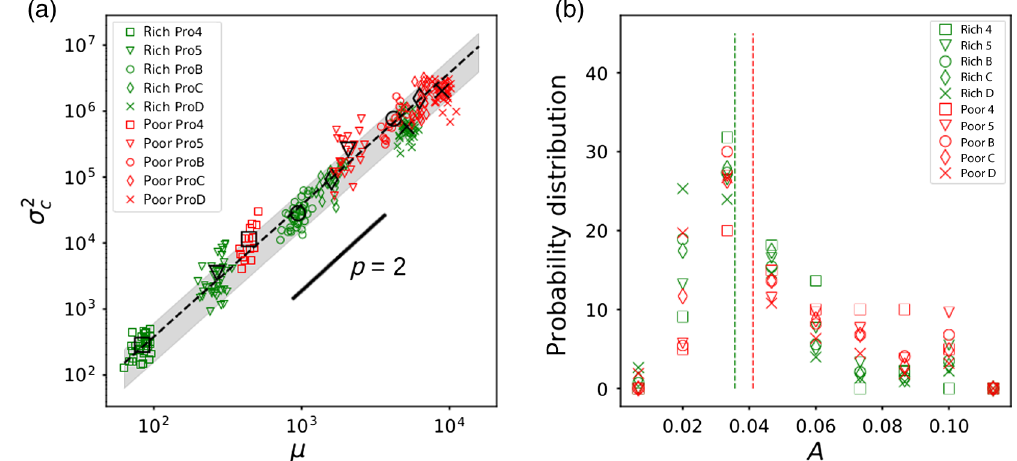
FIG. 2. TL in protein concentration fluctuations. (a) Variance ( σ 2 ) of the protein concentration versus the mean value μ ð¼ h c iÞ for c individual cells with all experimental conditions. The poor and rich nutrient conditions are labeled by red and green, respectively. Different symbols correspond to cells with promoters with different affinity to the sigma factor. All data from different cells with A μ 2 with A ¼ 0 . 038 (cid:2) 0 . 015 . The black dashed line and different promoters and growth condition are overlaid with the square TL: σ 2 c ¼ the gray thick line around it reflect the mean and standard deviation of the distribution of A , respectively. The bold black symbols represent the mean and variance averaged over cells with the same experimental conditions. (b) Distributions of A for all ten experimental conditions. The dashed lines indicate the means of A for all the cells in rich (green) and poor (red)